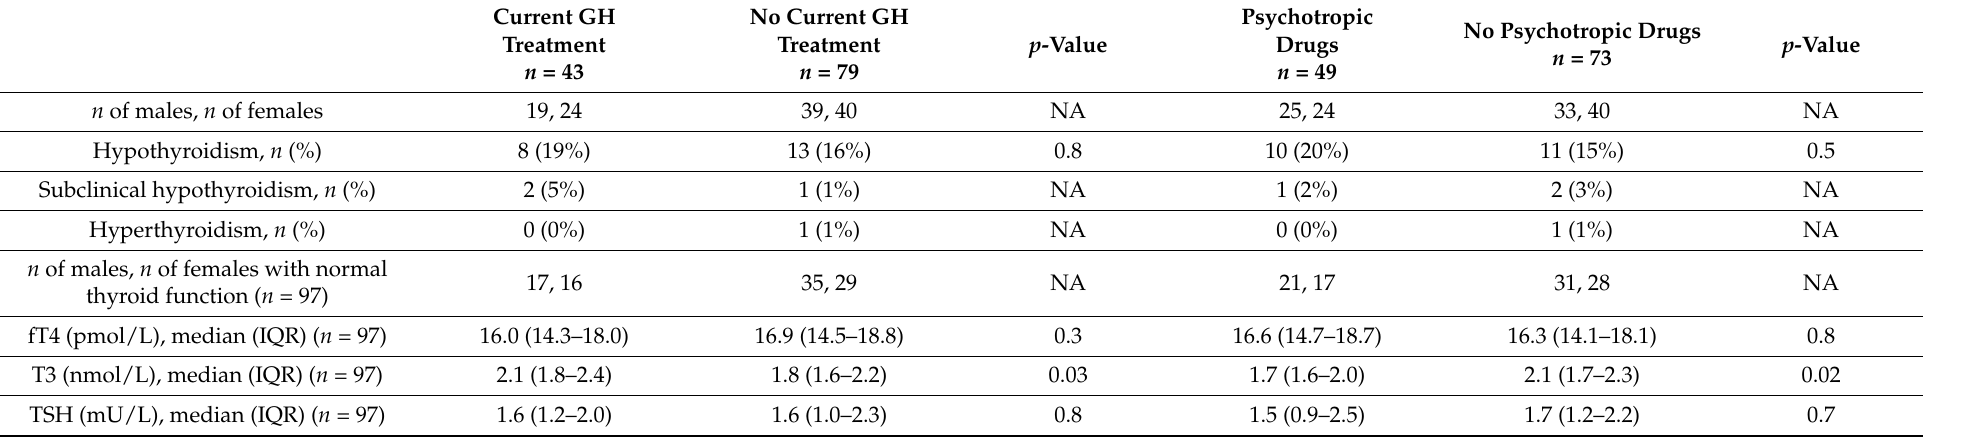
Table 4. Prevalence of hypothyroidism and thyroid hormone levels in 122 patients with PWS (Part